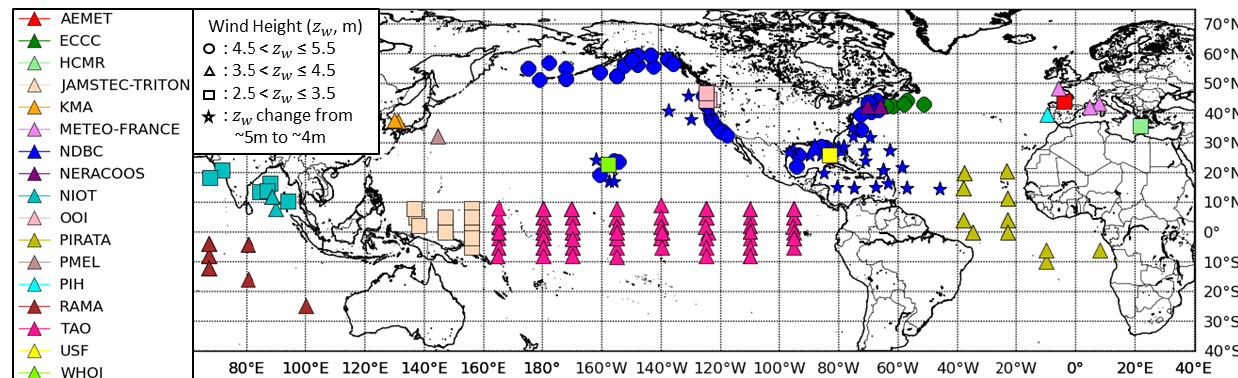
Figure 1. Locations of GTS buoys. Buoys are color coded by organization and the shape of the marker represents the buoy anemometer height.